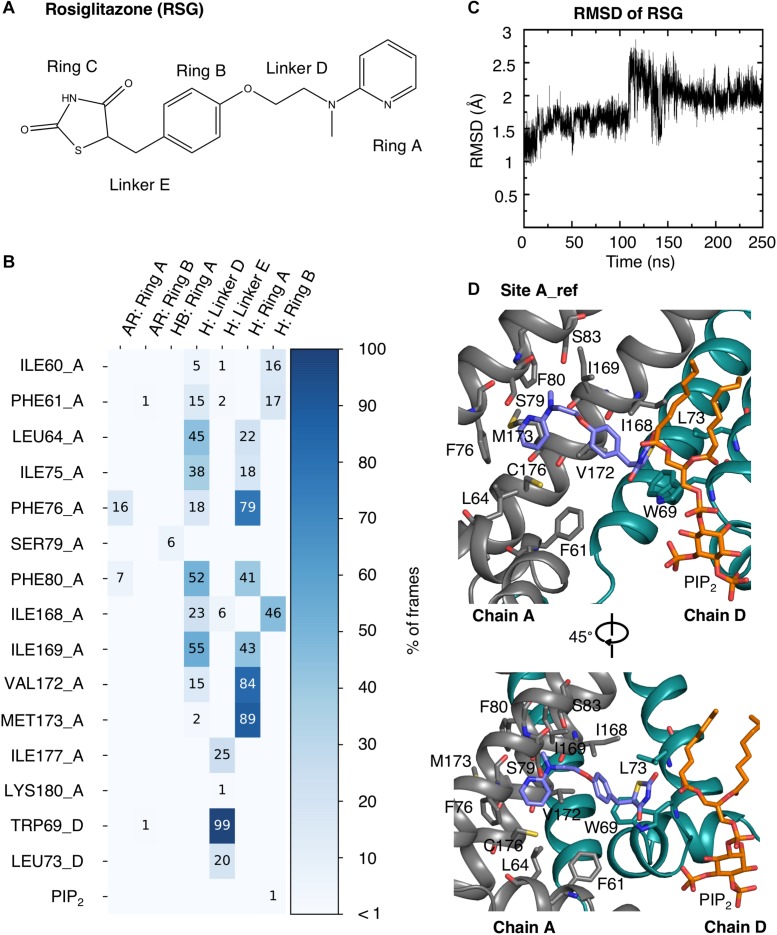
RSG interactions with the protein and PIP2 at binding site A_ref. (A) Molecular structure of RSG including the denotation corresponding to the interaction map. (B) Interaction map of RSG with protein and PIP2 during 200 ns MD simulation. The matrix is colored and numbered by the percentage of frames, in which interactions were observed: aromatic (AR), hydrophobic (H), and hydrogen bond (HB). The residues in the Kir6.1 are named by the corresponding amino acid with its residue number and chain ID (A or D). (C) RMSD plot of RSG at binding site A_ref during a 250 ns MD simulation. (D) Best PMF energy pose: Kir6.1 is represented as cartoon with two neighboring subunits colored in gray and green, respectively. RSG (purple), the surrounding residues within 3.5 Å, and the PIP2 (orange) are shown as stick.